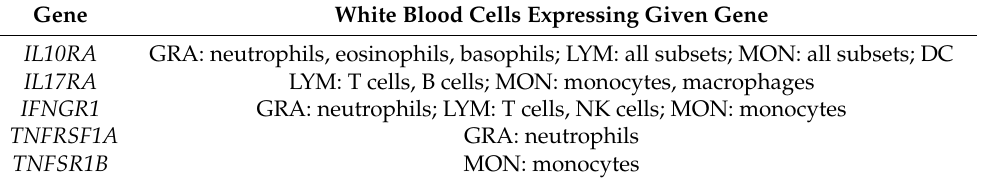
Table 1. Cont. Gene White Blood Cells Expressing Given Gene